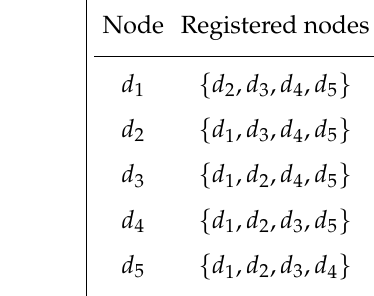
Figure 3. Node discovery.